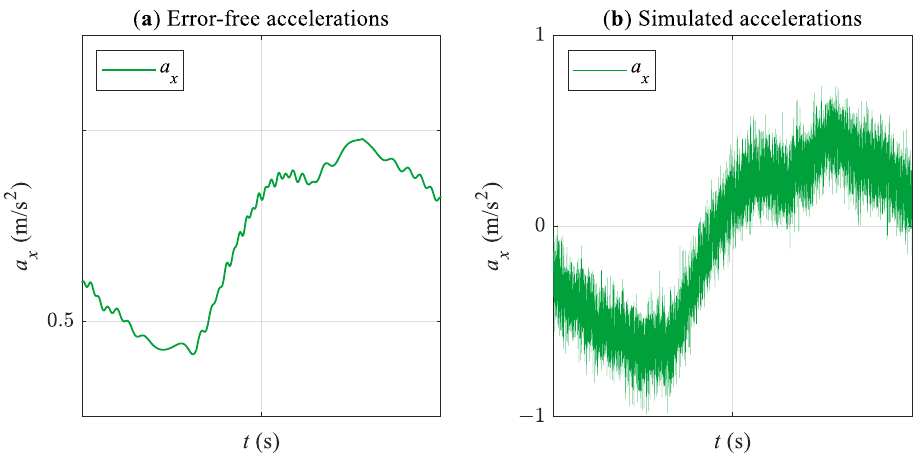
Figure 10. Noise and high-frequency components in simulation. ( a ) error-free accelerations; ( b ) simulated